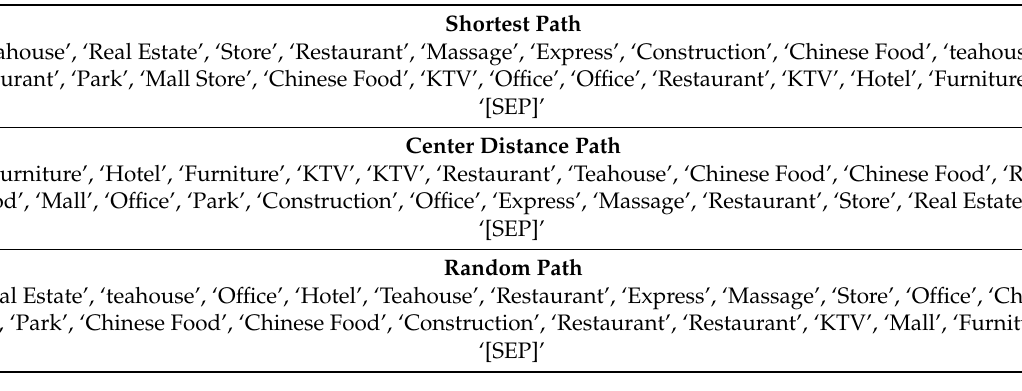
Table 16. Example POI sequence for attention